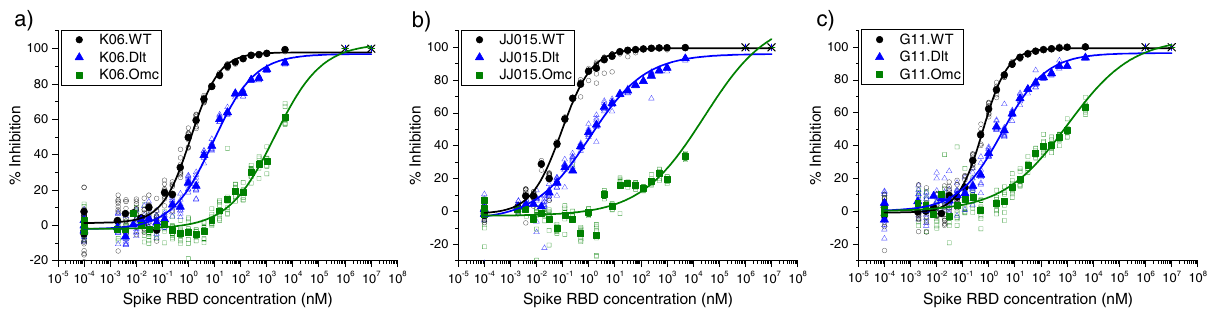
Fig. 1 Representative antibody binding curves toward SARS-CoV-2 RBD variants. Binding curves for interactions between patient antibodies and RBD from the WT (black circles), Delta (blue triangles), and Omicron (green squares) variants of SARS-CoV-2 are shown for three representative, single individuals who received either ( a ) P fi zer, ( b ) J&J, or ( c ) Moderna vaccination. For each representative individual, the binding curves for Delta- and Omicron-RBD show clear shifts to the right, indicating weaker af fi nities of the individual ’ s anti-spike antibody. Fixed, pseudo-100%-inhibition points for Delta- and Omicron-RBD ( “ * ” symbols) were appended to all data sets at 1 mM and 10 mM prior to the fi t (see Methods). Solid symbols: average, open symbols: nine technical